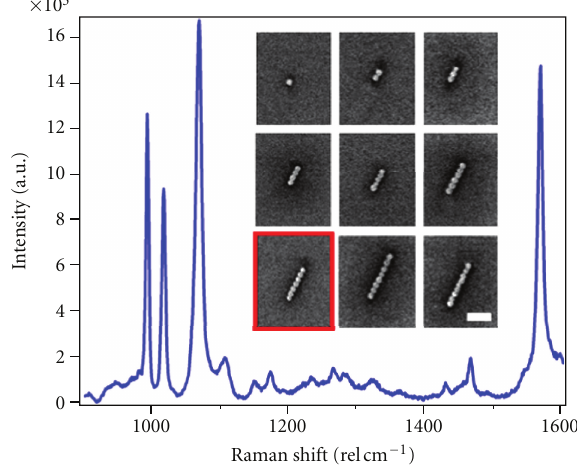
Figure 4: (a) Scanning-electron micrograph of gold nanochains ranging 1–9 particles in length. Scale bar is 300nm. (b) SERS spectrum of benzenethiol on a nanochain comprised of 60 nm gold nanospheres. Measurements were taken with a 632.8 nm laser source polarized parallel to the nanochain axis. The red box in (a) denotes the heptamer from which this measurement was